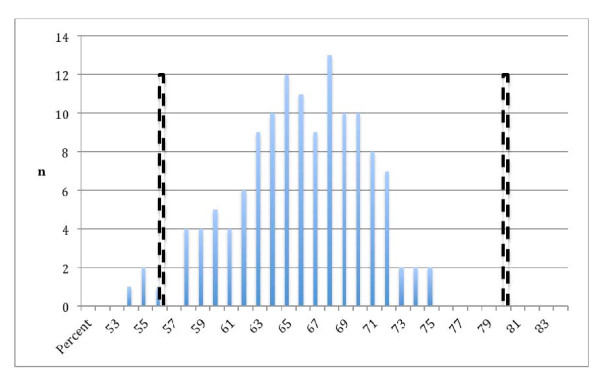
Frequency distribution of scores of 5th Year medical students sitting a 158 questions Script Concordance Test. Solid bars show students’ scores. Broken bars show the mean score of experts in the same test and the pass/fail cut point of >4 SD below the mean of the experts’ scores in the same test.